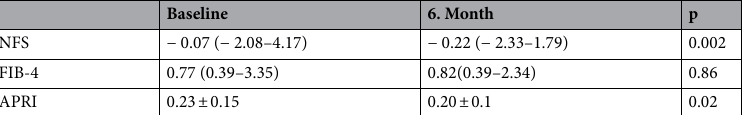
Baseline 6. Month